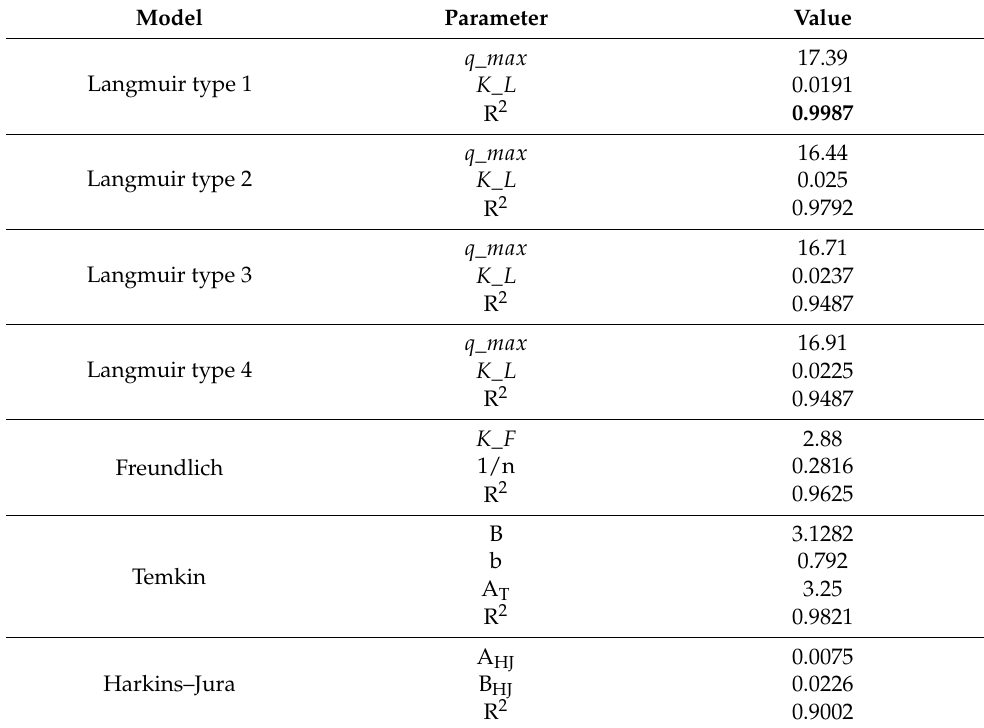
Table 3. The correlated parameters of isotherms of Cu (II) adsorption onto FA/Fe 3 O